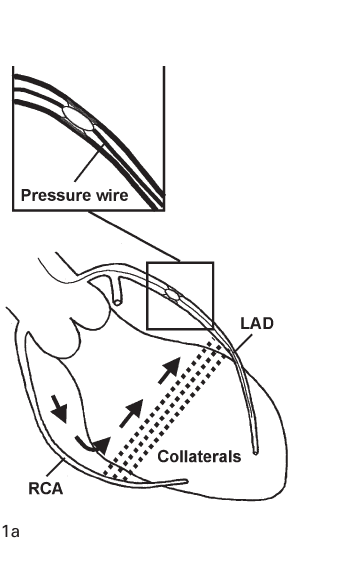
Figure 1a shows the inflated balloon across a stenosis in the LAD in a patient with coronary collaterals insufficient to prevent myocardial ischemia. Coronary perfusion pressure deter- mined by the blood flow distal to the occluded stenosis (i.e. collateral flow) is mea- sured (P occl ) via the pressure wire located distal to the stenosis. Collateral flow index (CFI) is calculated as indicated in figure 1b. ST-segment elevations are observed in the intracoronary ECG during balloon occlusion